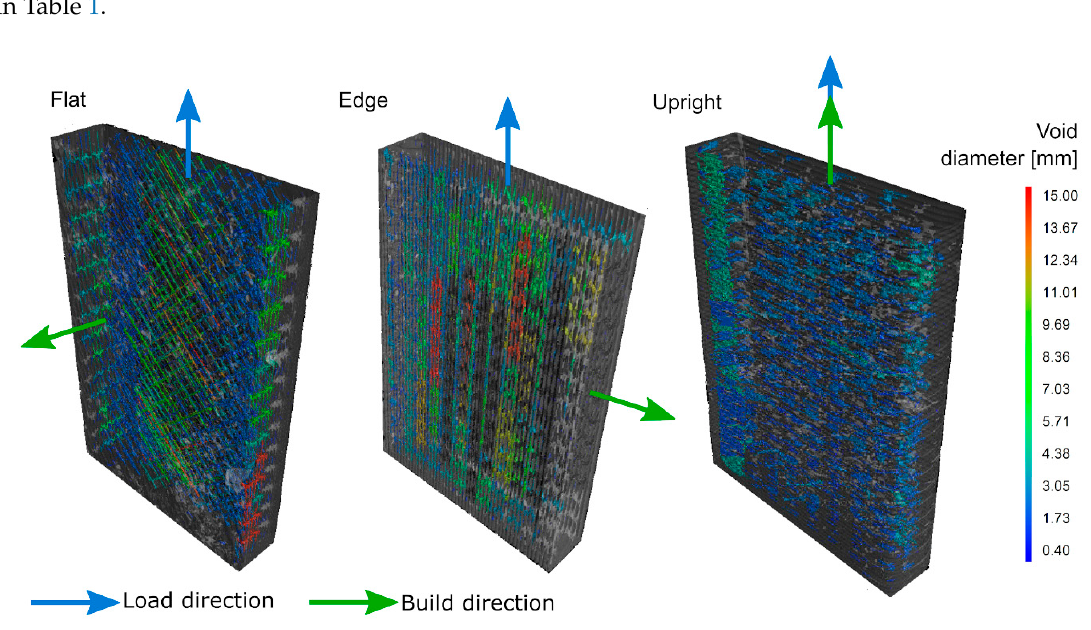
Figure 3. Voids visualization from CT (computed tomography) scanned samples. Table 1. Defect detection mean ( μ ) and standard deviation ( s ) of void characteristics for tensile samples.